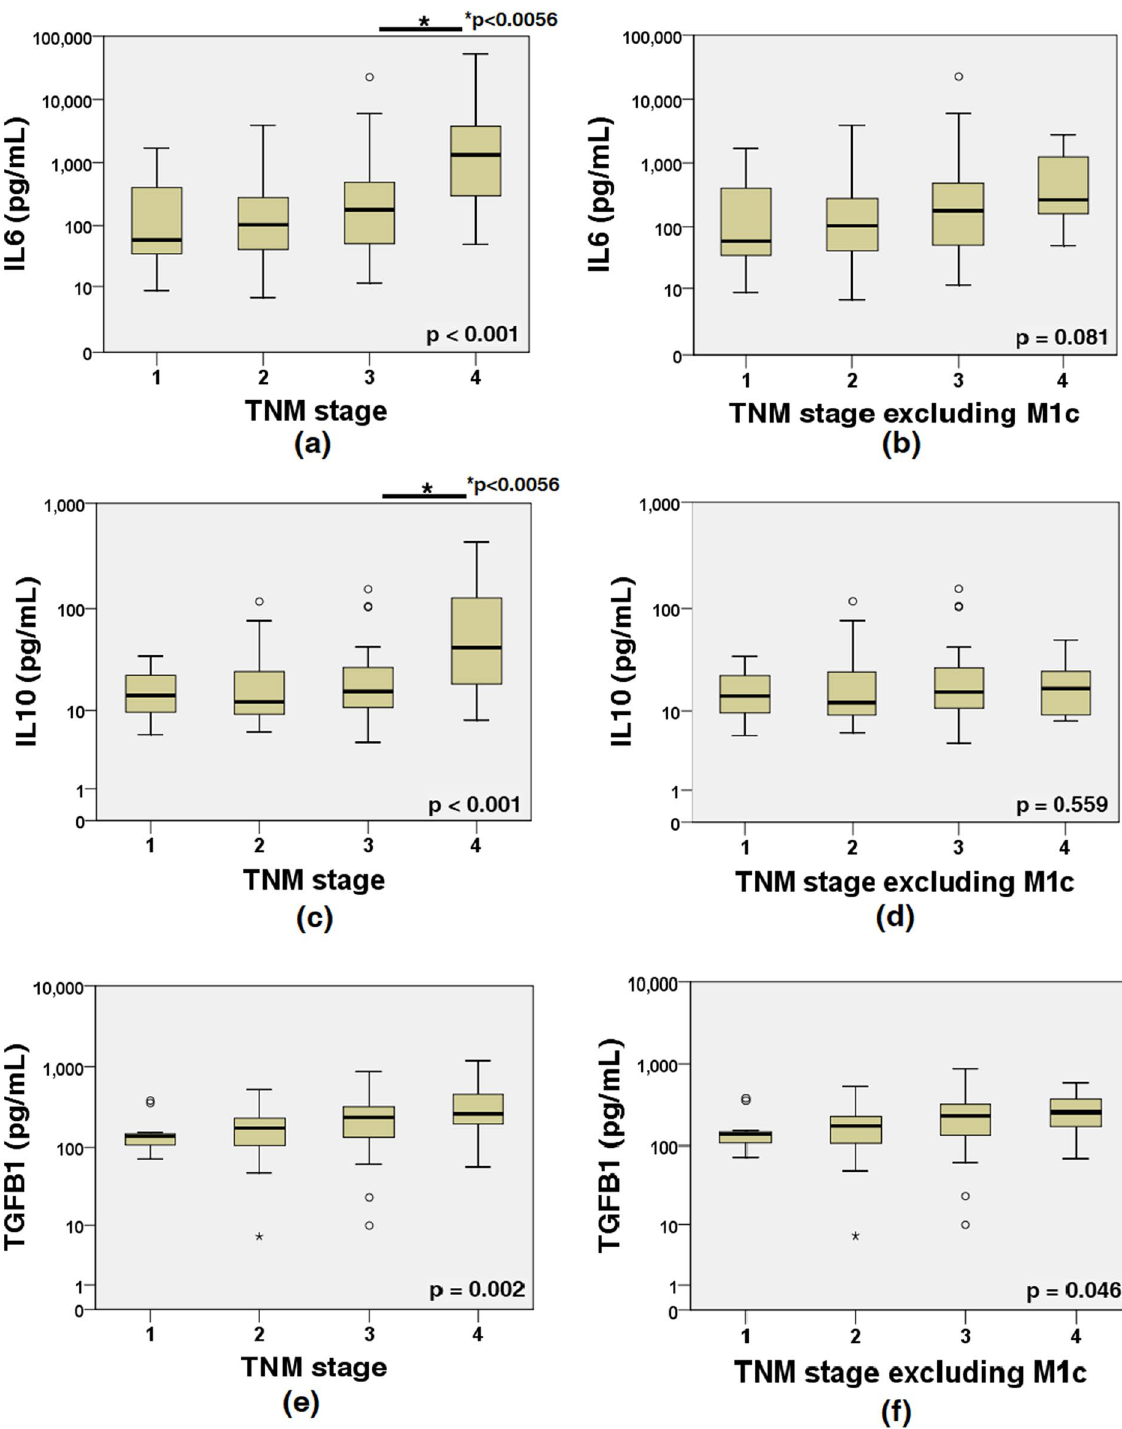
Figure 3. Cytokine concentrations in ascitic fluid according to TNM stage. ( a ) Peritoneal IL6 levels were higher in stage IV patients (p < 0.001 for stage III vs IV). ( b ) However, the peritoneal IL6 level of stage IV patients was not different if M1c patients were excluded (p = 0.170 for stage III vs IV). ( c ) The peritoneal IL10 level was higher in stage IV patients (p < 0.001 for stage III vs IV). ( d ) However, the peritoneal IL10 level of stage IV patients was not different if M1c patients were excluded (p = 0.860 for stage III vs IV). ( e ) Peritoneal transforming growth factor beta 1 (TGFB1) levels according to TNM stage (p = 0.130 for stage III vs IV). ( f ) TGFB1 levels according to TNM stage after excluding M1c patients (p = 0.532 for stage III vs IV). Ordinates are plotted on a log